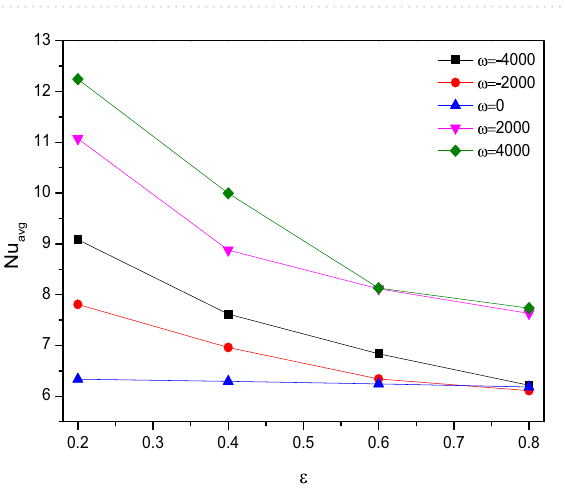
Figure 20. Variations of the streamlines ( (cid:31) ) and isotherms ( T ) with ε at Ra = 10 6 , Ha = 0 , Da = 0.01 , ω = 0 , N = 4 , r = 0.1 and φ = 0.02 .